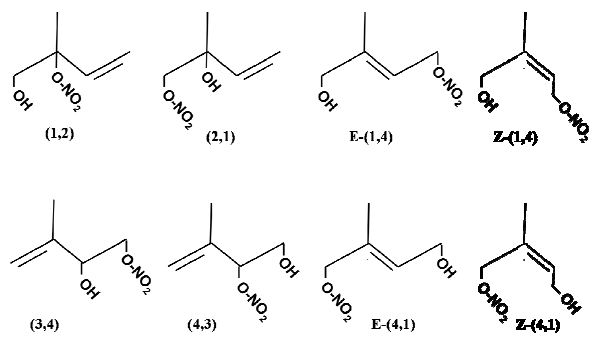
Fig. 1. Isoprene nitrate